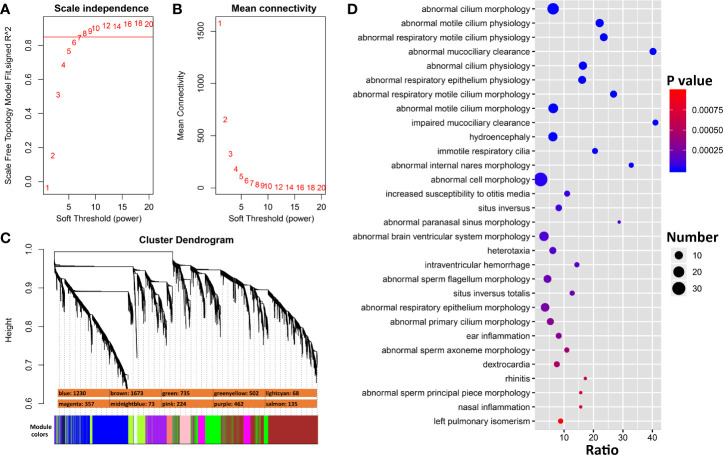
WGCNA modules associated with Ace2 expression in H1N1 infected lung. (A) The soft thresholding index R2 (y-axis) as a function of different powers β (x-axis) indicating the threshold of 8 chosen. (B) Mean connectivity (degree, y-axis) as a function of the soft-thresholding power (x-axis). (C) 10 co-expression modules identified from Ace2 correlated genes. Modules are color coded as shown. The number of genes in each module is also indicated. (D) Bubble charts of top 30 enriched Mammalian Phenotype Ontologies of the purple module. Analysis by WebGestalt.